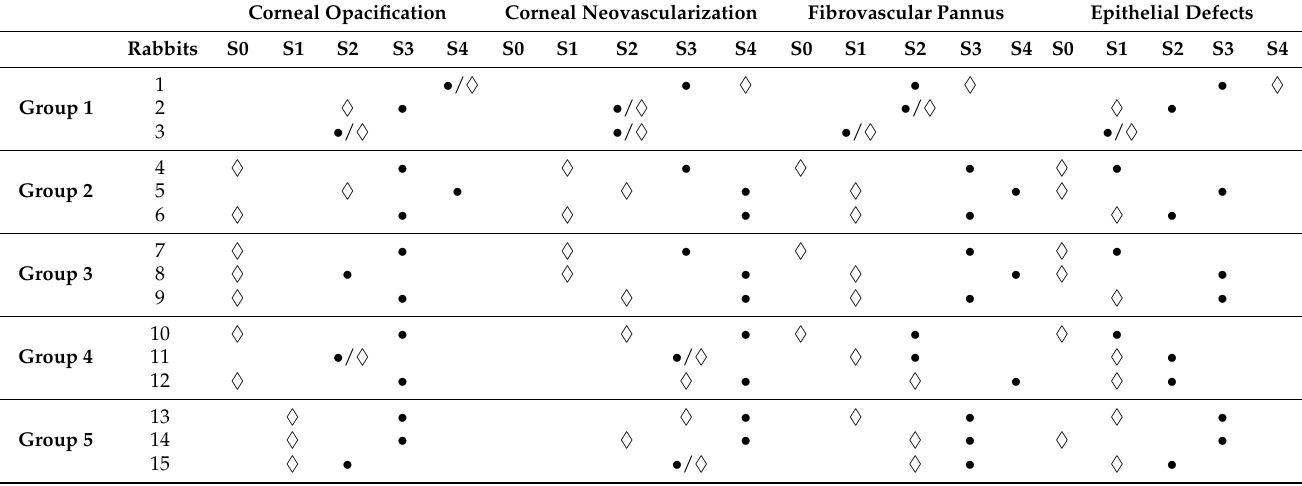
• : pre-treatment; ♦ : post-treatment. Group 1: only medical treatment (control group), Group 2: fibrin-PRGF membrane cultured with autologous rabbit LEPCs, Group 3: fibrin-PRGF membrane cultured with heterologous rabbit LEPCs, Group 4: fibrin-PRGF membrane SLET and Group 5: fibrin-PRGF membrane without rabbit cultured LEPCs. PRGF: Plasma Rich in Growth Factors; LEPCs: Limbal Epithelial Progenitor Cells; SLET: Simple Limbal Epithelial